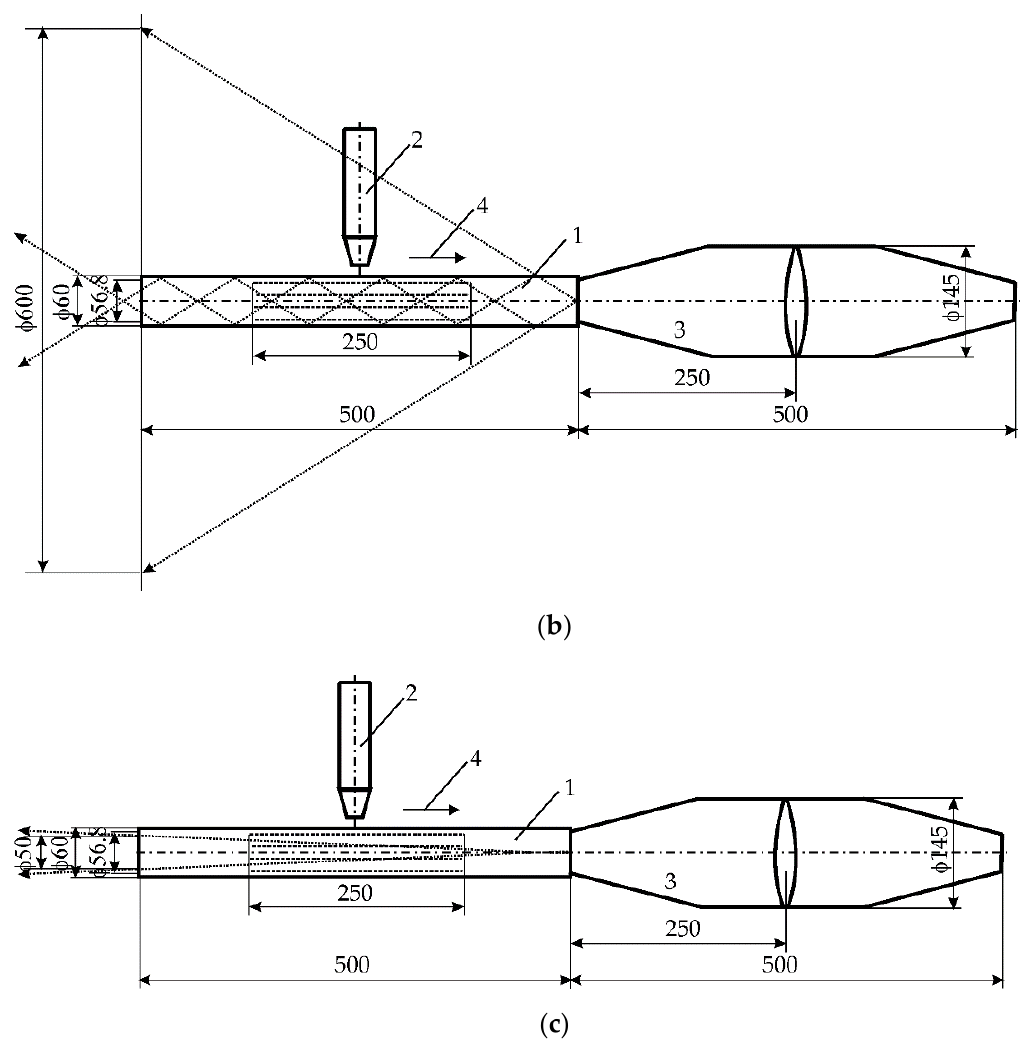
Figure 28. The beam of vibrations in the air inside the pipe: ( a ) vibrations with a frequency of 50 Hz, ( b ) vibrations with a frequency of 110 Hz, ( c ) vibrations with a frequency of 1385 Hz (all dimensions in mm).